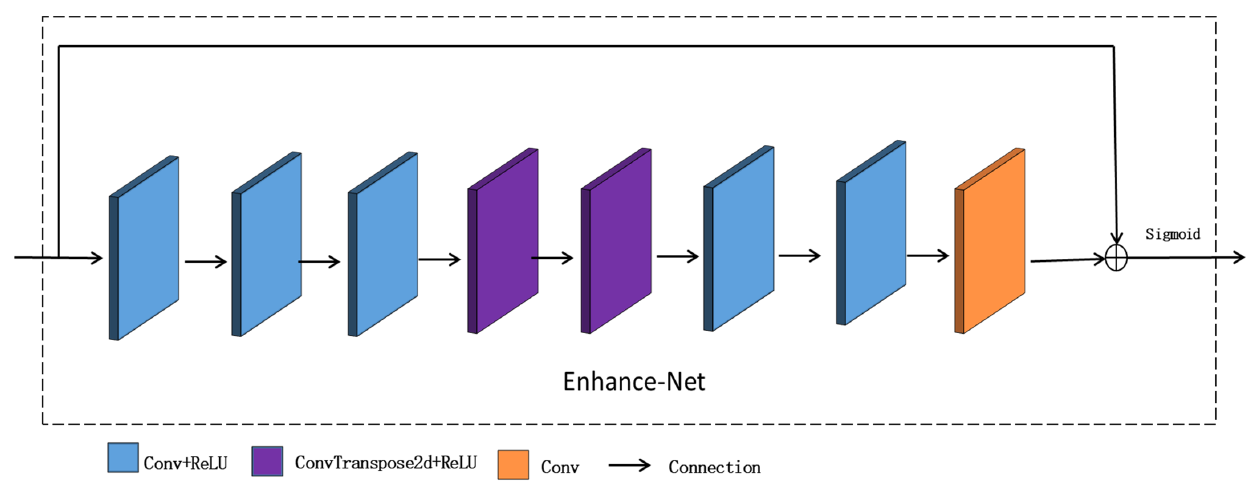
Figure 3. The model structure diagram of the Enhance-Net.